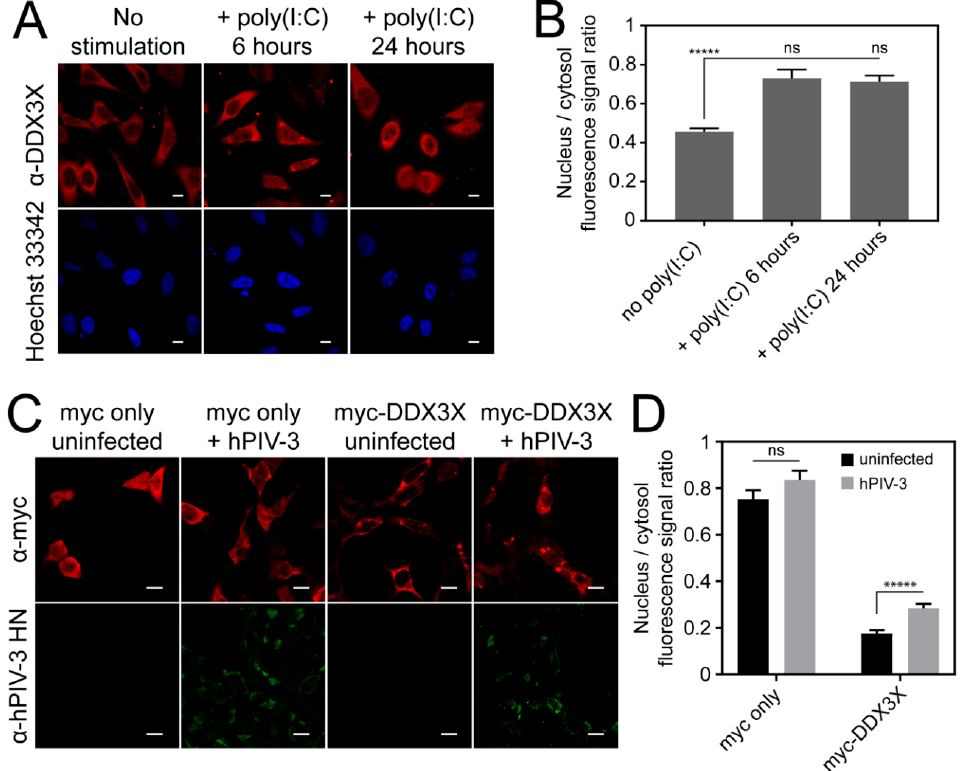
Figure 4. DDX3X nuclear localization increases during virus infection in response to invasive RNA. ( a ) Human cervical epithelium adenocarcinoma (HeLa) cells transfected with 20 µM poly(I:C) or carrier (H 2 O) for 6 or 24 h, then fixed and immunostained using α -DDX3X antibody, counterstained using Hoechst 33342 and visualized by CLSM. Representative cell clusters shown. ( b ) Quantitation of